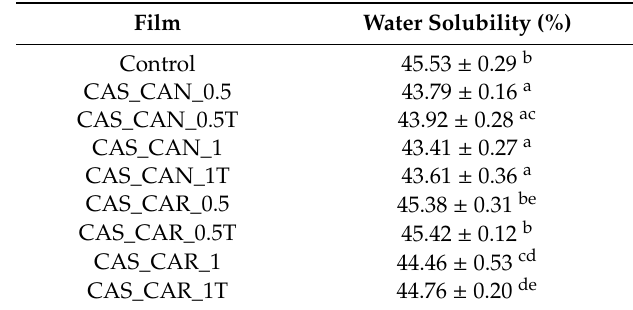
Table 3. Water solubility of sodium caseinate films with candelilla and carnauba